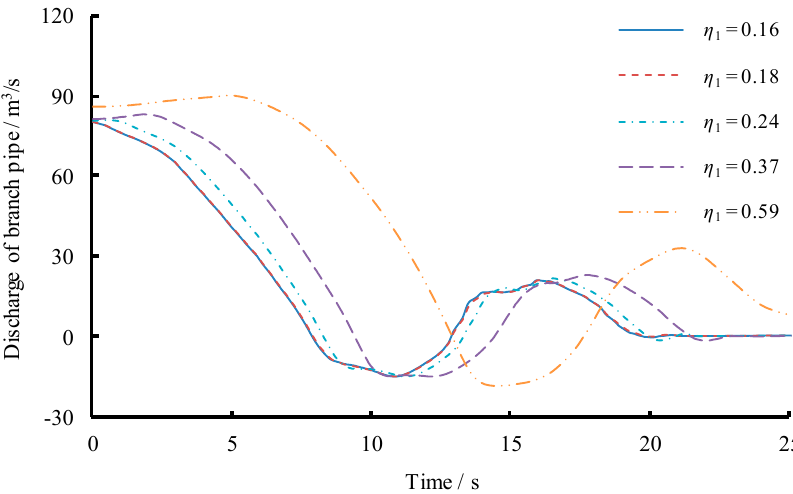
Figure 16. Branch pipe discharge of different η 1 versus time for Scenario 2.